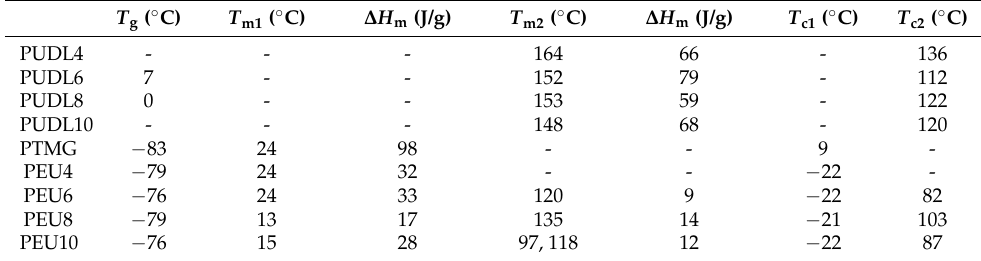
Table 3. Thermal parameters of PUDL, PTMG and